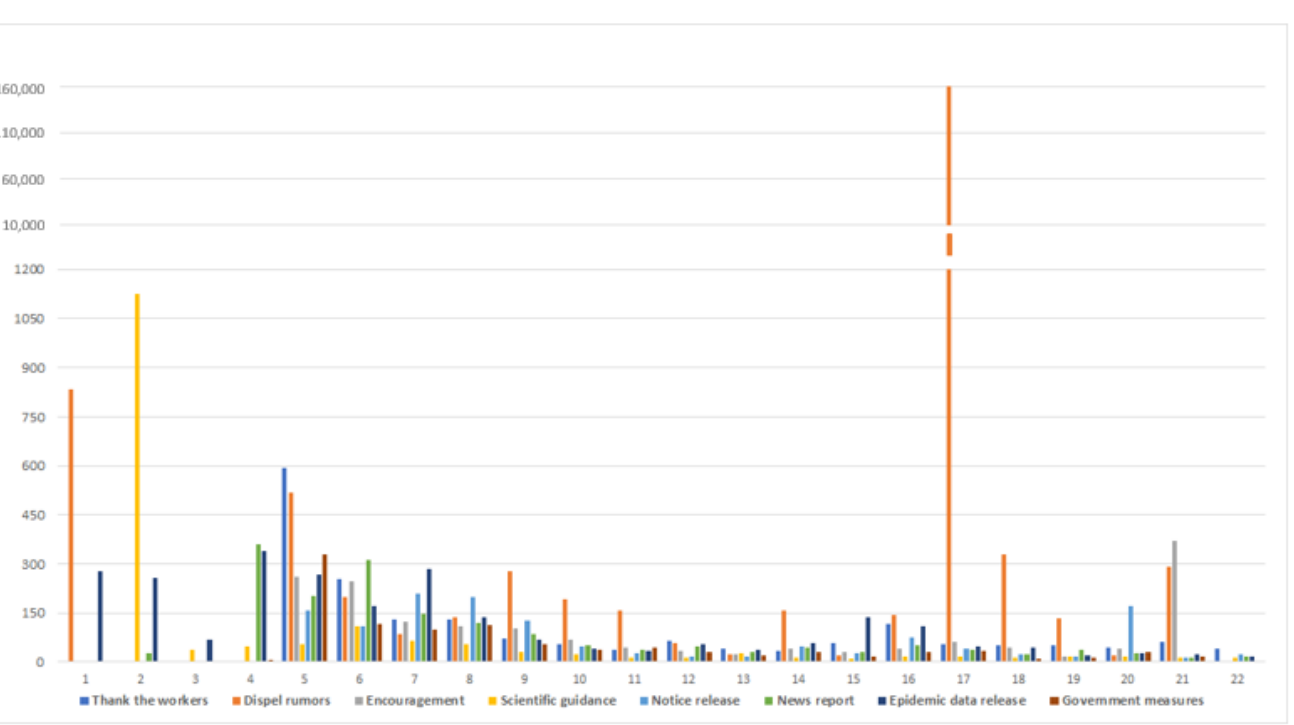
Figure 4. Median Likes count for 8 categories of content.